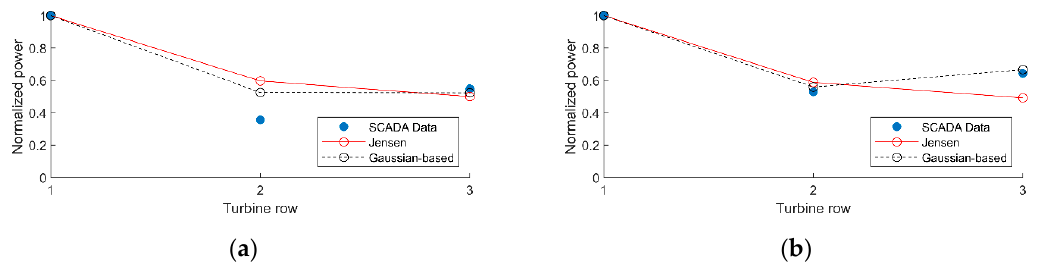
Figure 10. Layout of the three turbines array.